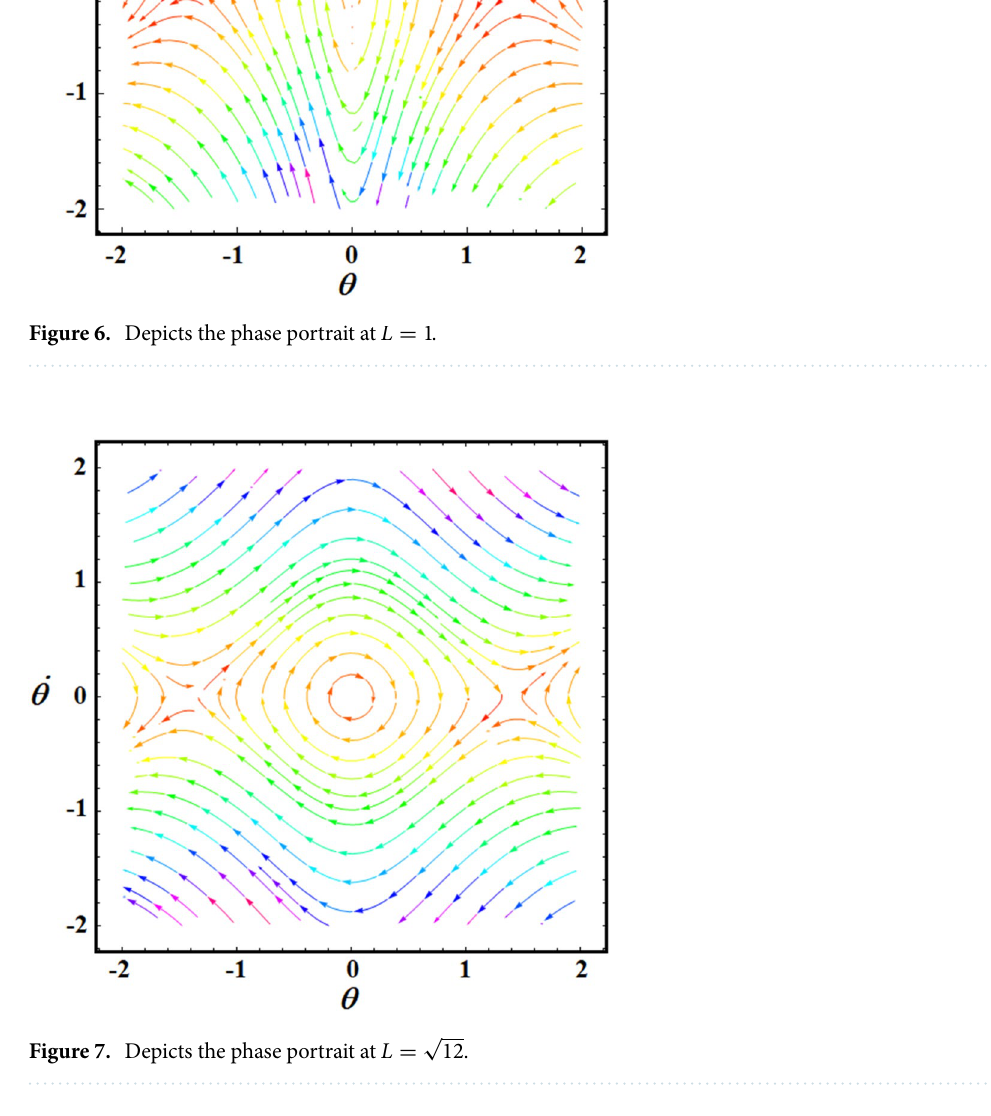
Figure 7. Depicts the phase portrait at L =